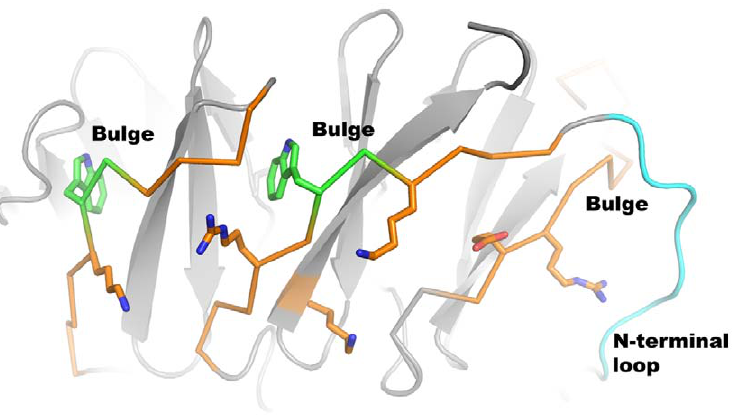
Figure 5. Features preventing b -augmentation in D strands of BamB. Three D-strands of BamB are shown as an orange alpha-carbon trace displaying three features that disfavors b -augmentation: The tryptophan in the docking motifs introduces a bulge in the strand (green) and strategically placed charged residues would have to be buried for extension of the sheets. The N-terminal loop also protects one D strand from b-